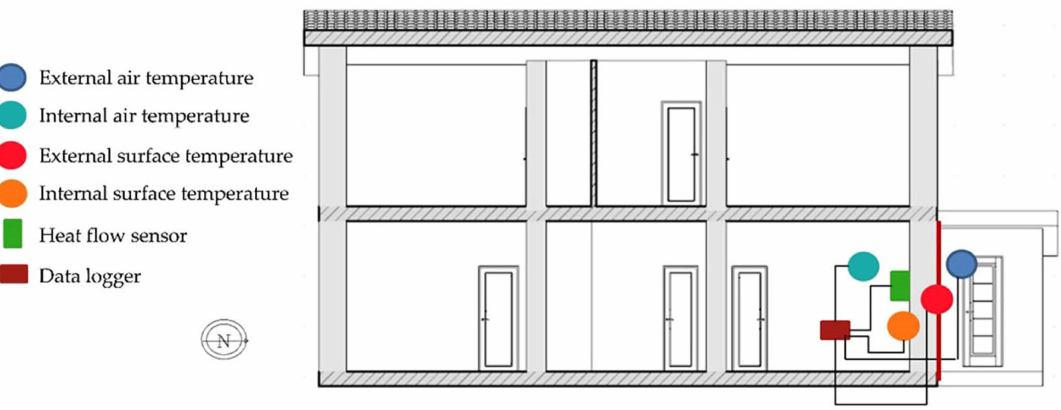
Figure 11. Monitoring instrumentation